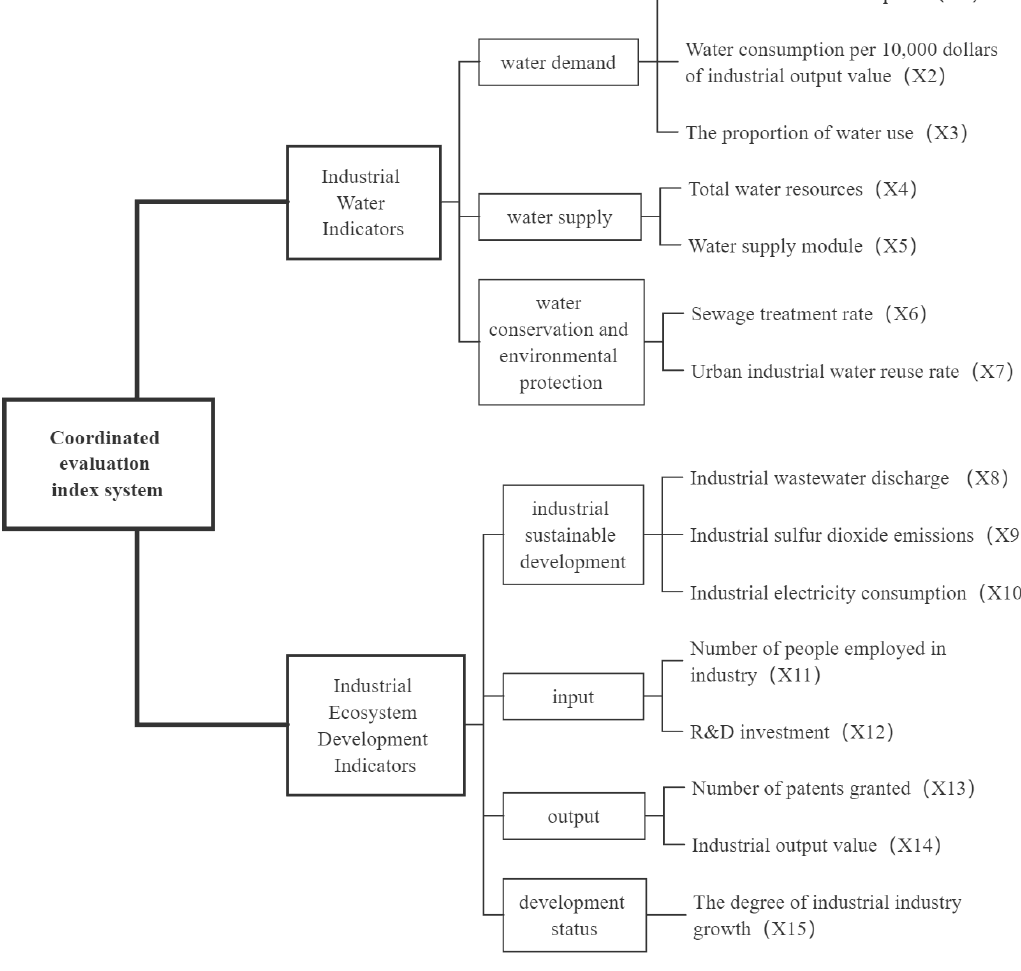
Figure 1. Coordinated evaluation index system.